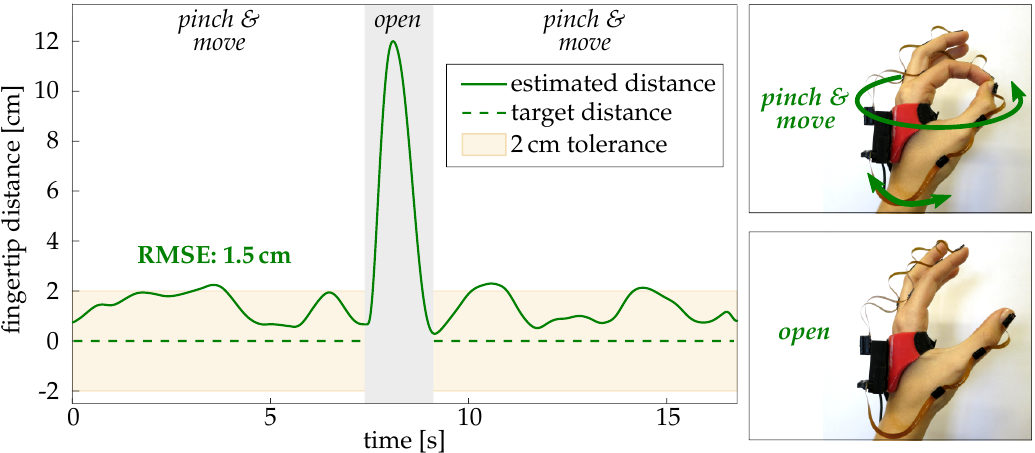
Figure 15. Representative time series of a pinch motion (experiment P3). The measured distance between tip of F1 and F2 (solid green line) is close to the true value (0 cm; dashed green line). d Note that the pinch was released during the gray marked time